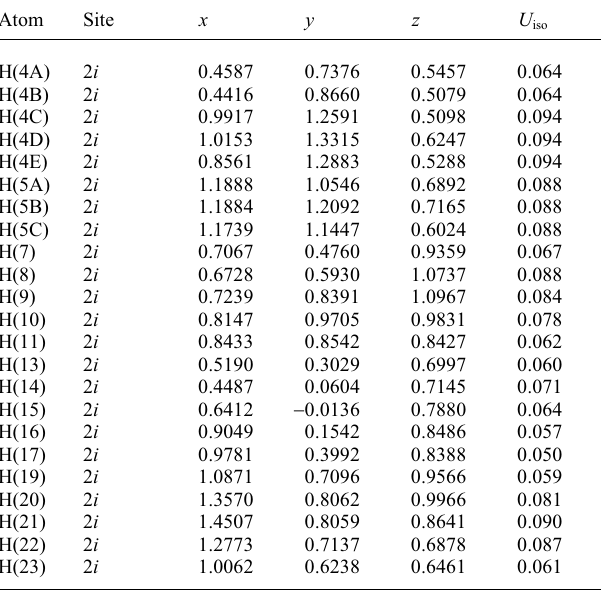
Table 2. Atomic coordinates and displacement parameters (in Å 2 )